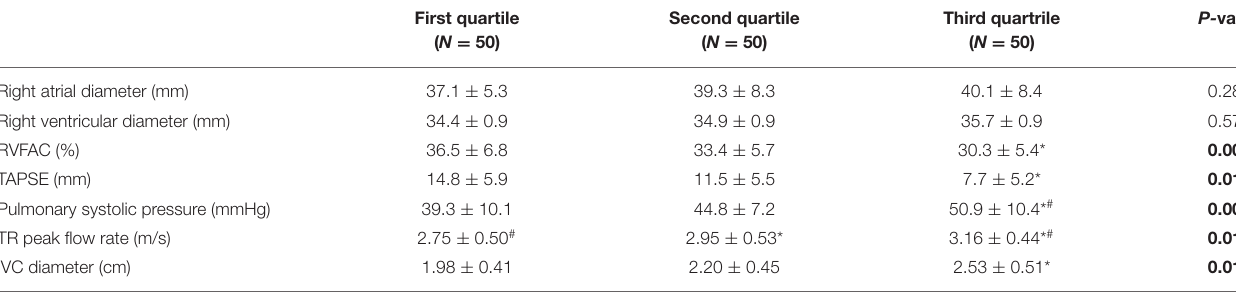
TABLE 4 | Comparison of right heart function in HFpEF patients of different liver hardness